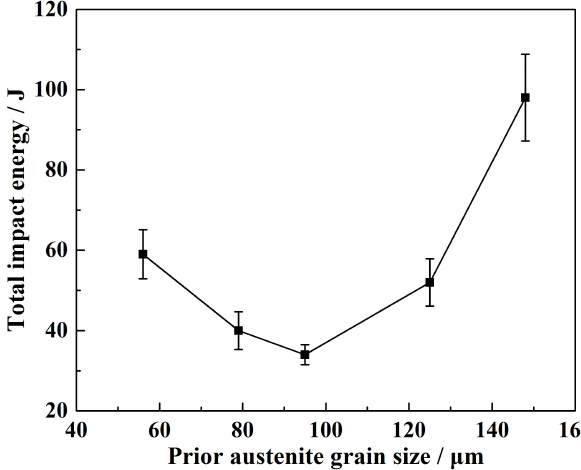
Figure 10: Total impact energy of the simulated CGHAZ as function of the prior austenite grain